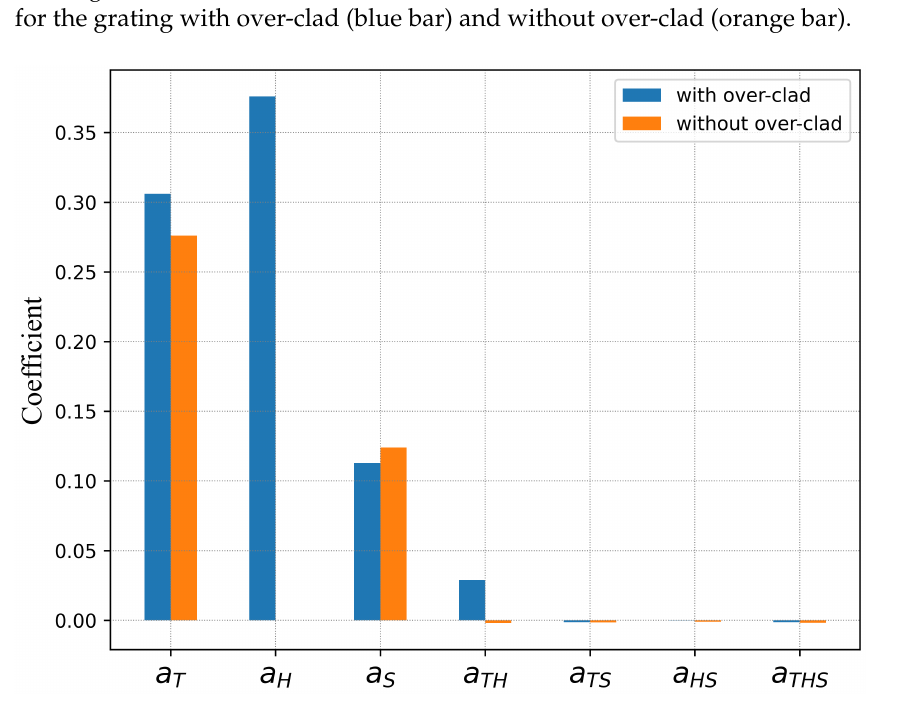
Figure 4. Relative distribution of the normalized main and cross-interaction sensitivities in CYTOP fiber with and without the